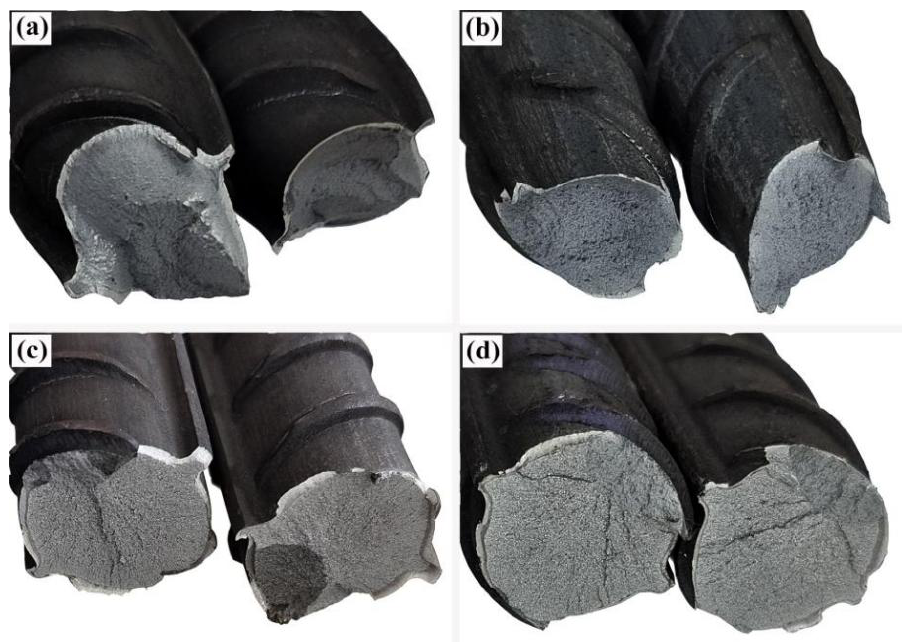
Figure 11. Macroscopic morphology of the tensile fractures for various rebars: ( a ) 20MnSiV/316L rebar; ( b ) 35#/316L rebar; ( c ) 45#/316L rebar; ( d ) 55#/316L rebar.